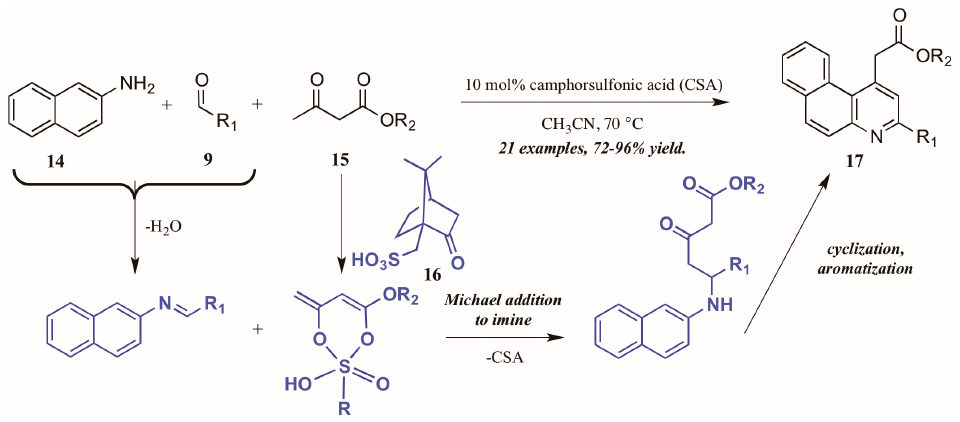
Figure 10. Acid-catalyzed multicomponent Conrad–Limpach reaction.